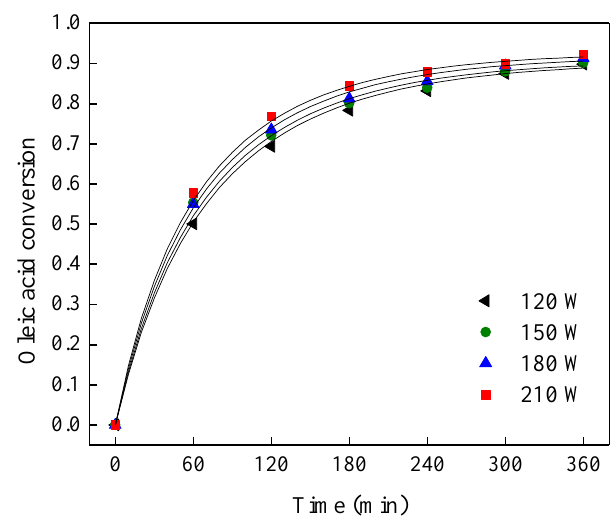
Figure 4. Influence of microwave power on esterification reaction. Reactions occurred at a molar ratio of ethanol to oleic acid of 2:1 and at a temperature of 433 K.